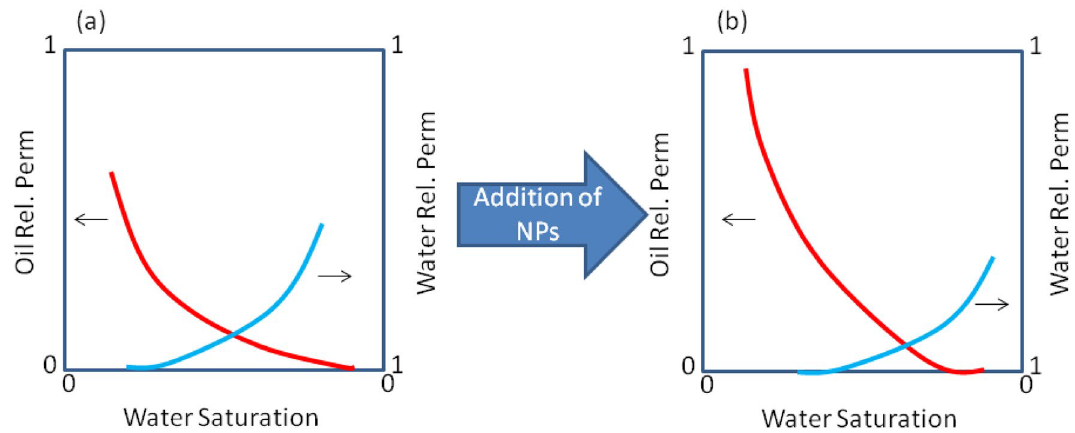
Fig. 7 a Relative permeability curves in an oil-wet rock b and after the addition of NPs which results in wettability